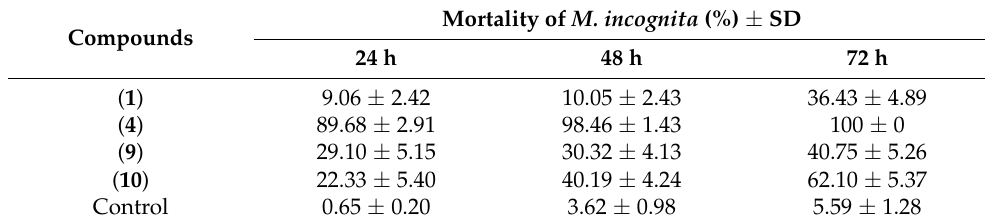
Table 1. The nematicidal activities of compounds against M. incognita . Compounds